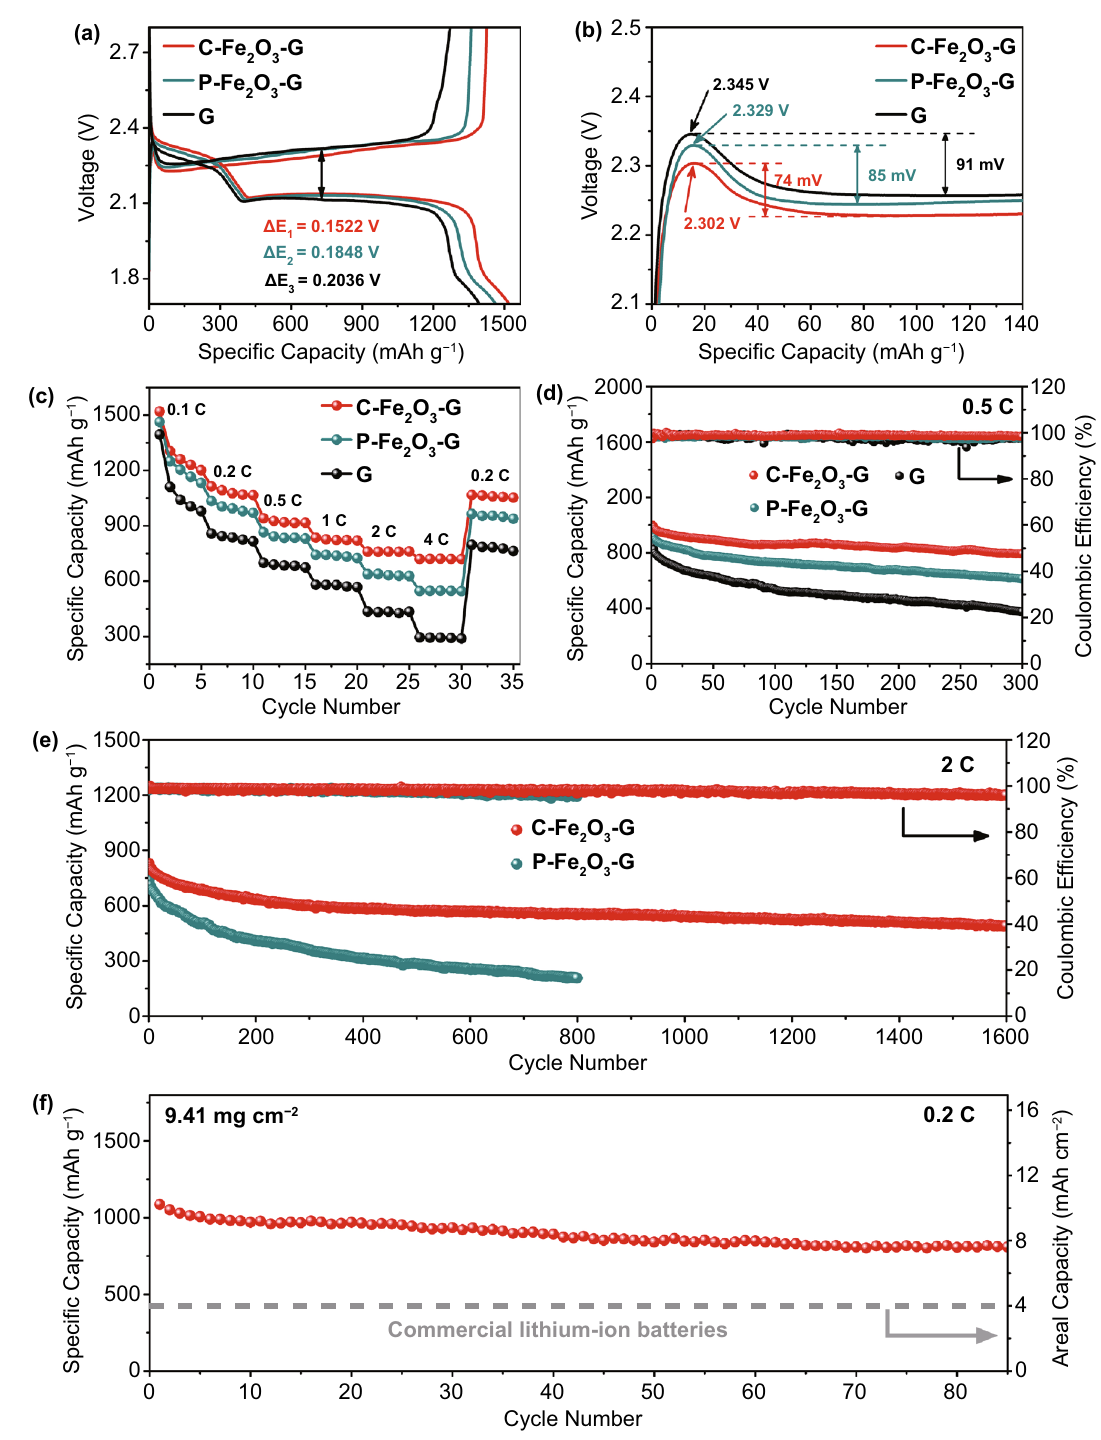
Fig. 4 a Galvanostatic charge/discharge profiles and b charge voltage profiles of C-Fe 2 O 3 -G, P-Fe 2 O 3 -G and G cells at 0.1C. c Rate capacities and d cycle performance at 0.5 C of C-Fe 2 O 3 -G, P-Fe 2 O 3 -G and G cells. e Long-term cycle stability of C-Fe 2 O 3 -G and P-Fe 2 O 3 -G cells at 2 C. f Cycling performance of C-Fe 2 O 3 -G cell with high sulfur loading of 9.41 mg cm −2 at 0.2